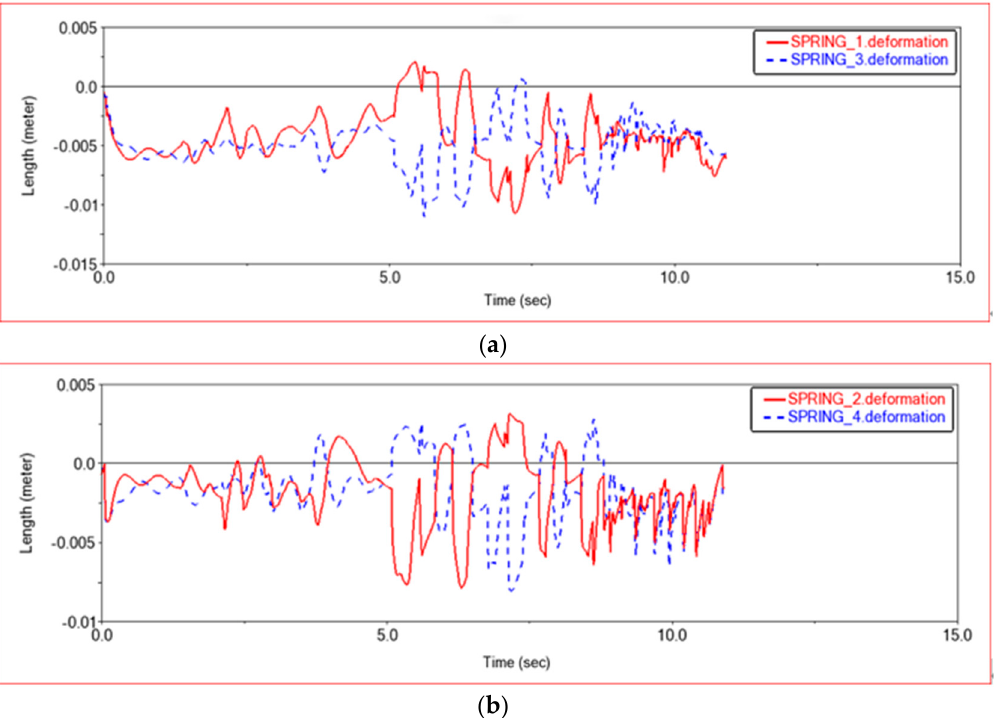
Figure 10. Deformation diagram of suspension shock absorber. ( a ) Deformation diagram of front suspension shock absorber, SPRING-1-Left front suspension shock absorber, SPRING-3-Right front suspension shock absorber; ( b ) Deformation diagram of rear suspension shock absorber. SPRING-2-Left rear suspension shock absorber; SPRING-4-Right rear suspension shock absorber.